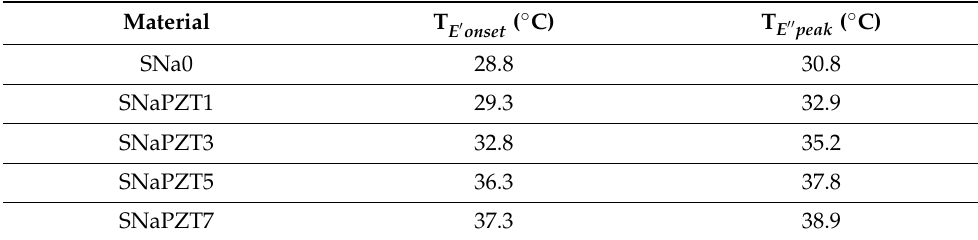
Table 2. Comparison between the results for T g, clusters (or t ord-disord ) of SNa0 and SNaPZT# films via DMA by using two different